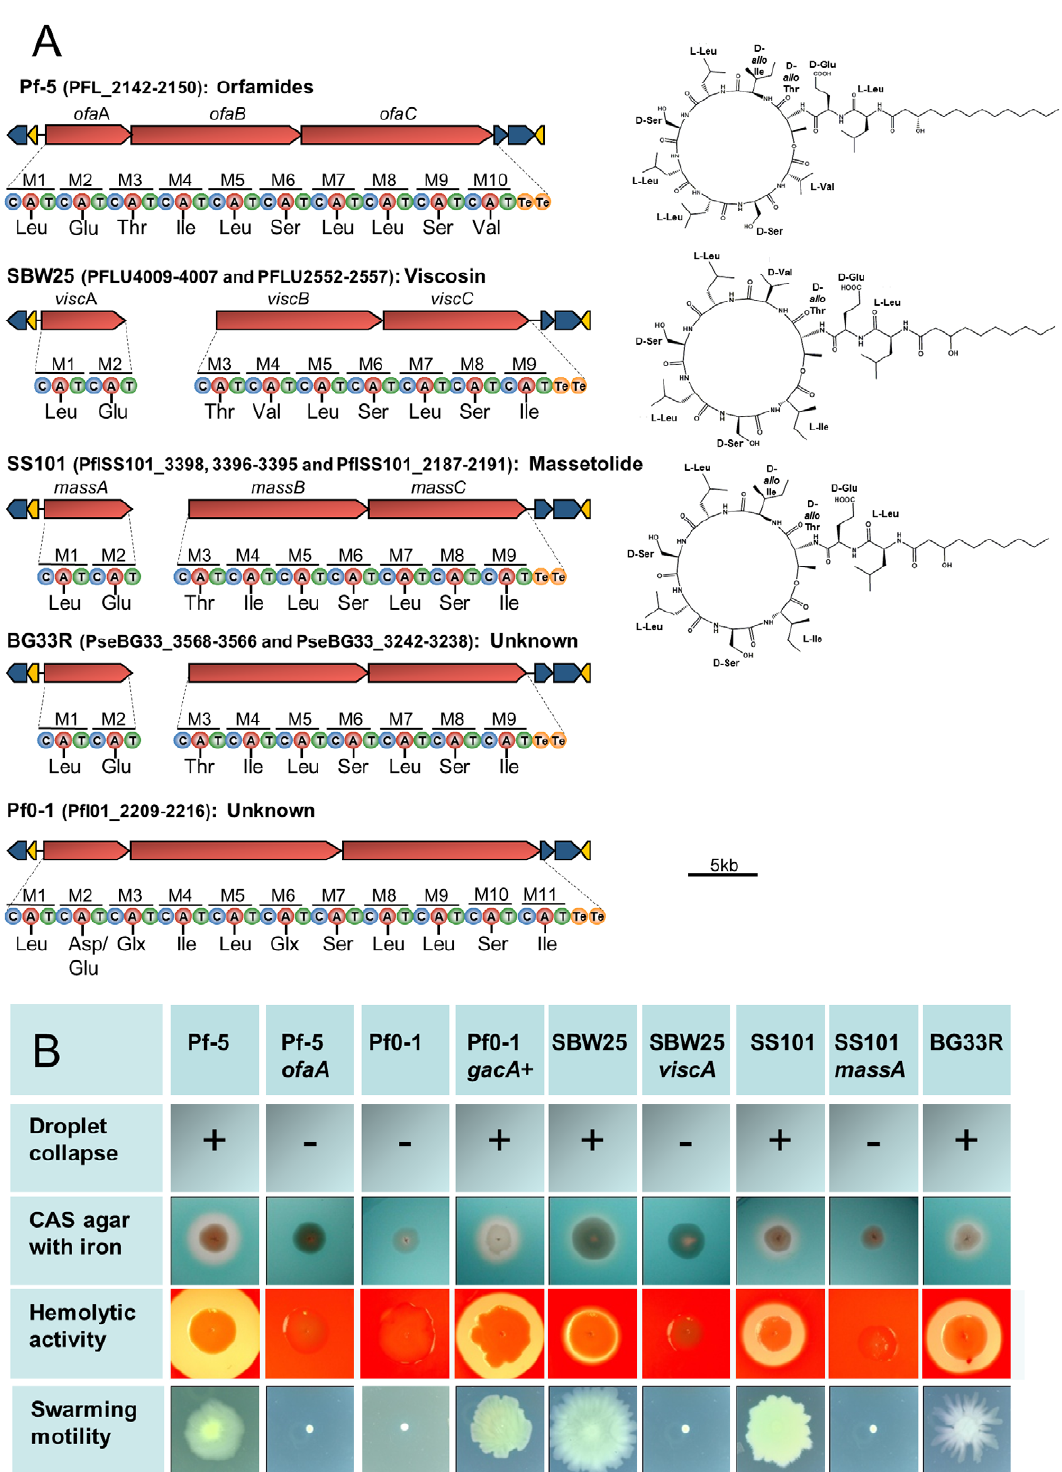
Figure 7. Biosynthetic gene clusters, predicted structures, and phenotypes associated with cyclic lipopeptide (CLP) production by strains in the P.fluorescens group. (A) Organization of the clusters and predicted amino acid composition of the CLP peptide chains in five genomes. NRPSs (red arrows) have nine to eleven modules (M1-M11) each containing a condensation (C), adenylation (A), and thiolation (T) domain, with two thioesterase domains (Te) at the terminus. Amino acids predicted to be incorporated into the CLP peptide are shown beneath each adenylation domain. Structures of orfamide A [35], viscosin [60], and massetolide [59] are shown to the right of the corresponding gene clusters. The organization of the biosynthetic clusters, which include genes encoding LysR regulators (yellow arrows) and efflux proteins (blue arrows), is similar among the genomes. (B) Phenotypes associated with CLP production. Strains Pf-5, SBW25, SS101 and BG33R, which have CLP biosynthetic clusters, exhibited surfactant activity, determined by a droplet collapse assay; produced zones on CAS agar containing 0.1 mM FeCl 3 ; expressed hemolytic